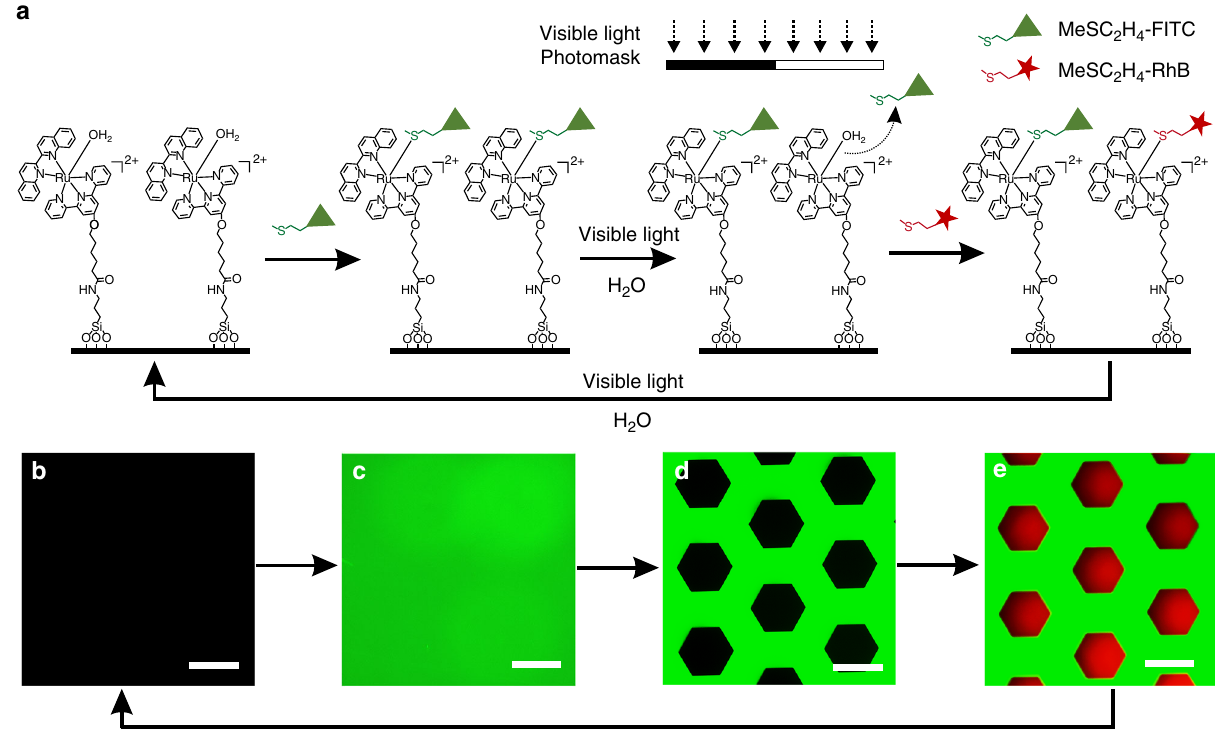
Fig. 3 Rewriting surface patterns on the Ru-H 2 O-modi fi ed substrate using visible light. a Schematic illustration of the rewriting surface patterns. The fl uorescence microscopy images of b the Ru-H fi ed substrate, c Ru-MeSC fi ed substrate, d patterned substrate consisting of a 2 O-modi 2 H 4 -FITC-modi Ru-MeSC 2 H 4 -FITC-modi fi ed part (green) and Ru-H 2 O-modi fi ed part (dark), and e patterned substrate consisting of a Ru-MeSC 2 H 4 -FITC-modi fi ed part (green) and Ru-MeSC 2 H 4 -RhB-modi fi ed part (red). Scale bars are 300 µ